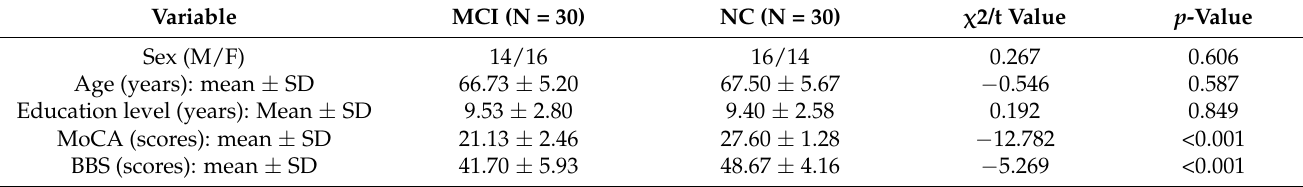
Table 1. Clinical characteristics of the participants.